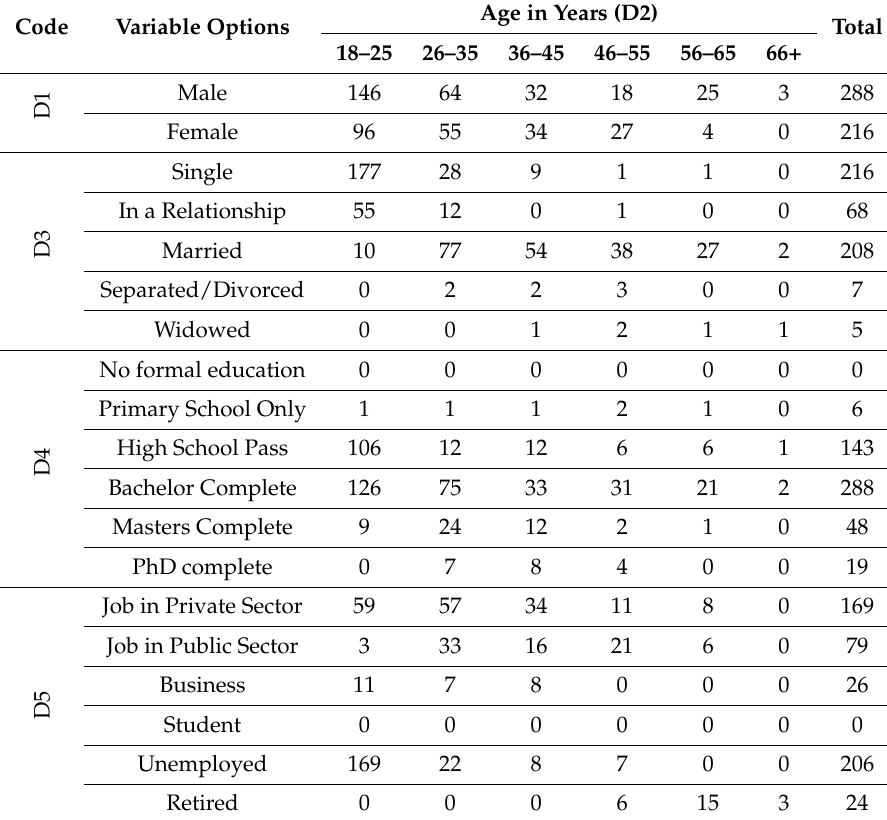
Table 2. Cross tabulation of Age in Year (D2) with Gender (D1), Relationship Status (D3), Educational Level (D4) and Employment Status